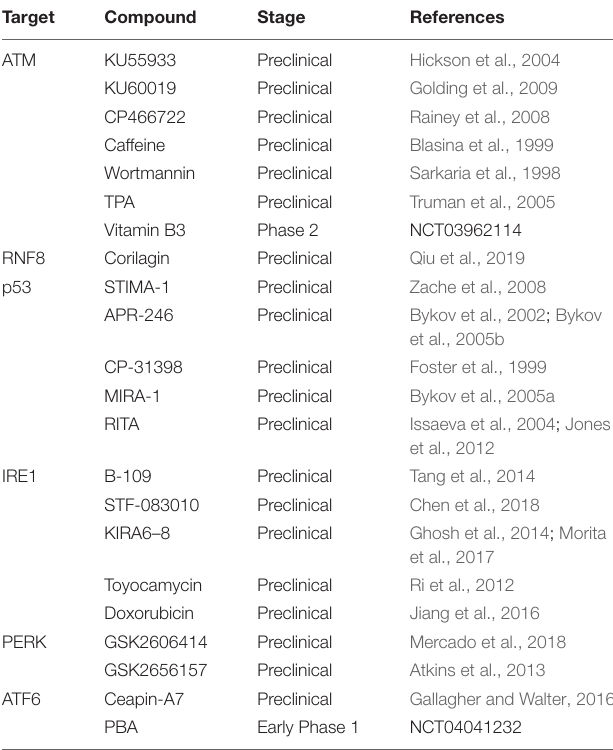
TABLE 1 | Pharmacological targeting of DDR